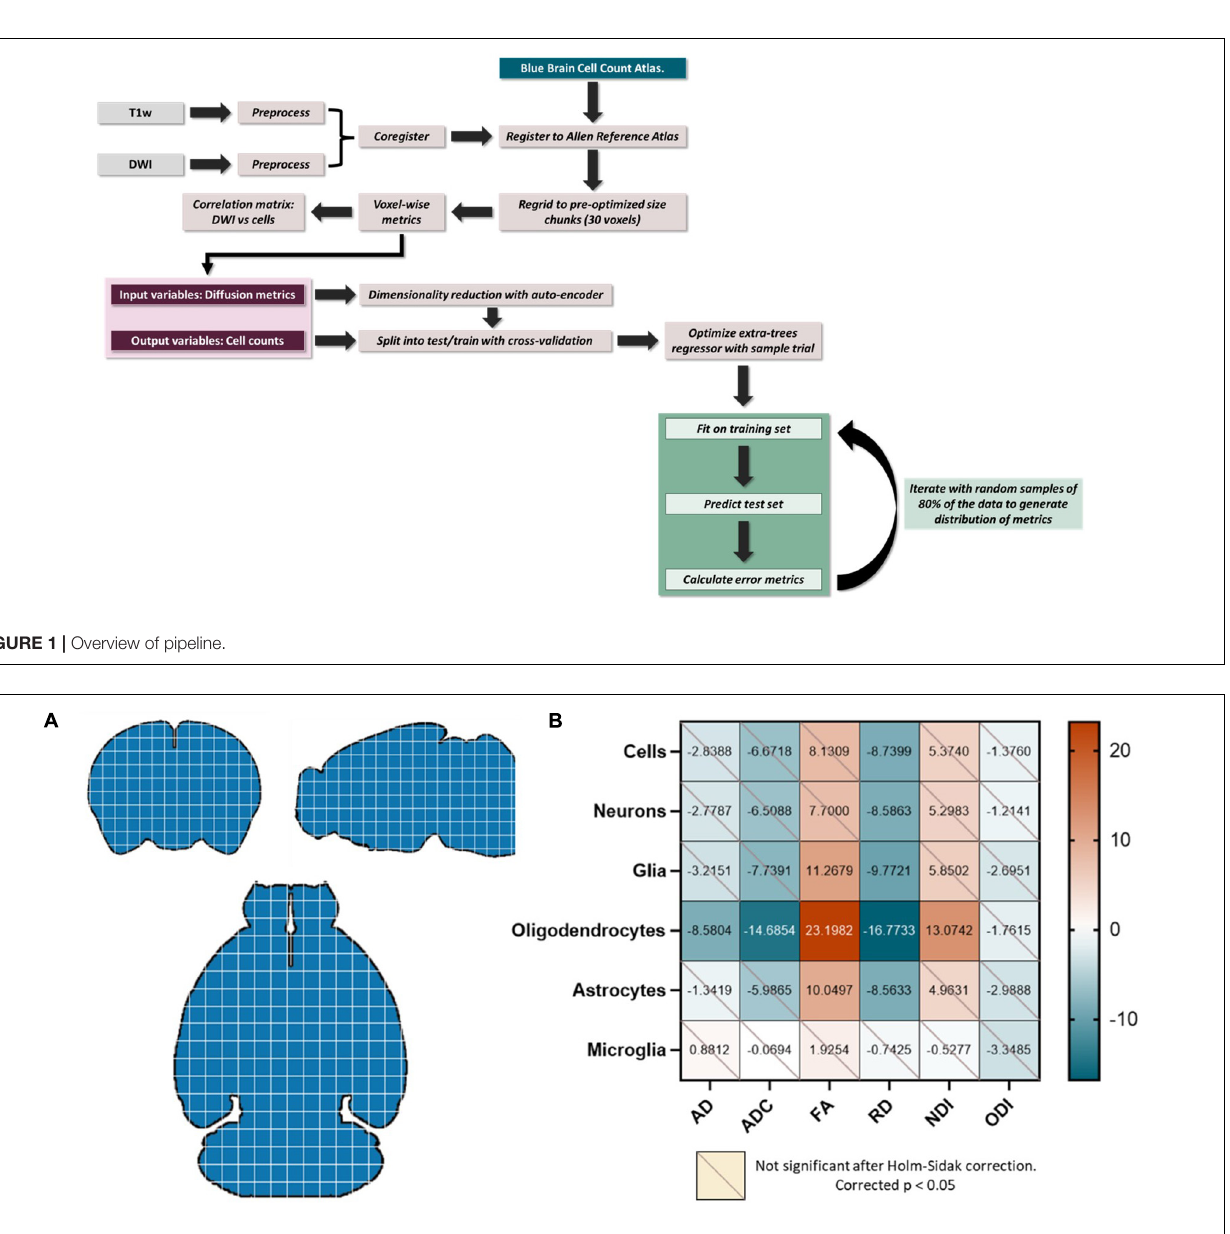
FIGURE 2 | (A) The whole brain was re-gridded into 30 × 30 × 30 voxels, and data points were generated by averaging the diffusion metrics and cell counts in each of these voxels for each mouse. Each blue square here represents a 30 × 30 × 30 voxel that was designated a unique value. (B) Oligodendrocyte counts were highly correlated with all diffusion metrics except the ODI. FA was positively correlated with glia and astrocytes as well; and RD was negatively correlated with all cell types except microglia. Values in the correlation matrix represent the t -value from a one-sample t -test of the Z-score of the Pearson correlation coefficient of each subject’s pair. “Cells” represent counts of all cell types studied, and “Glia” is the sum of oligodendrocyte, astrocyte and microglia